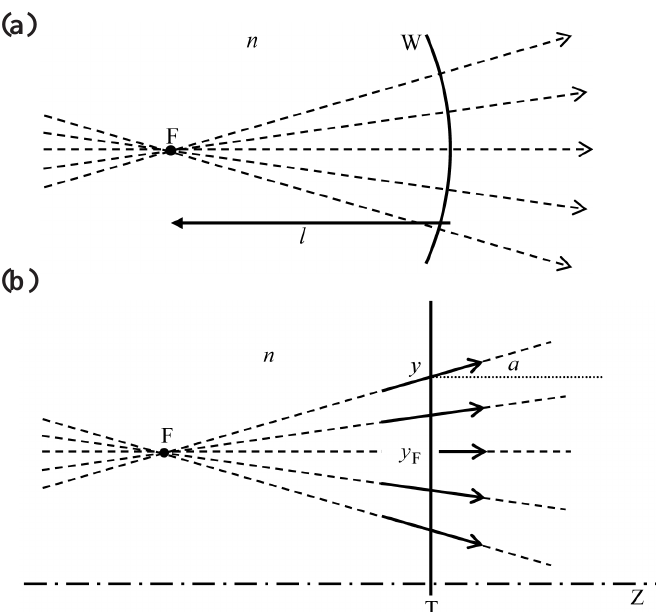
Figure 1 Vergence defined in terms of a wavefront W (a) and in terms of rays